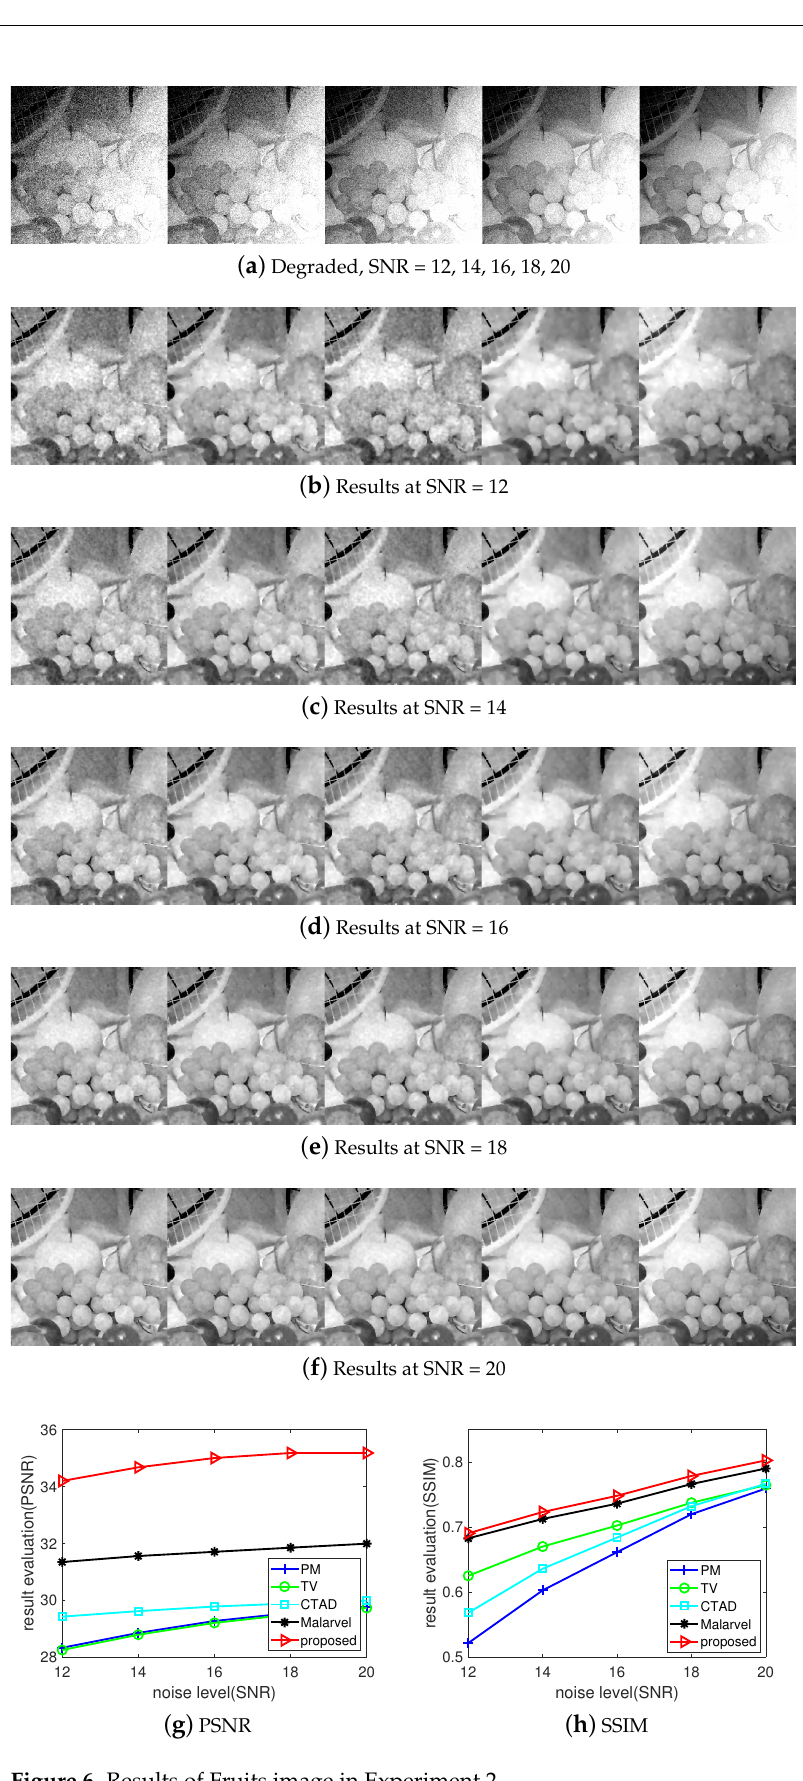
Figure 6. Results of Fruits image in Experiment